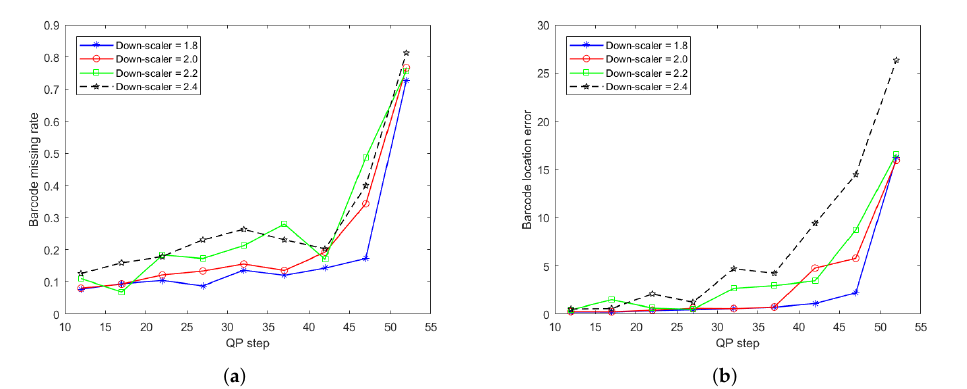
Figure 14. ( a ) Barcode’s missing rate (%) and ( b ) barcode’s location error (cm) against QP and down